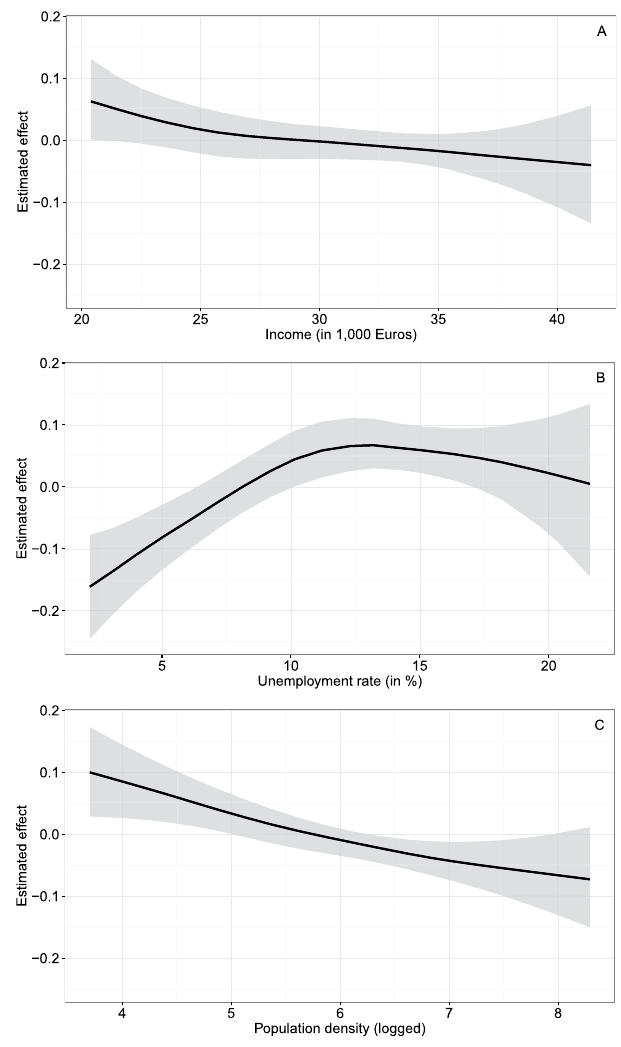
Figure 3. Non-linear risk factors for income (A), unemployment rate (B), and population density